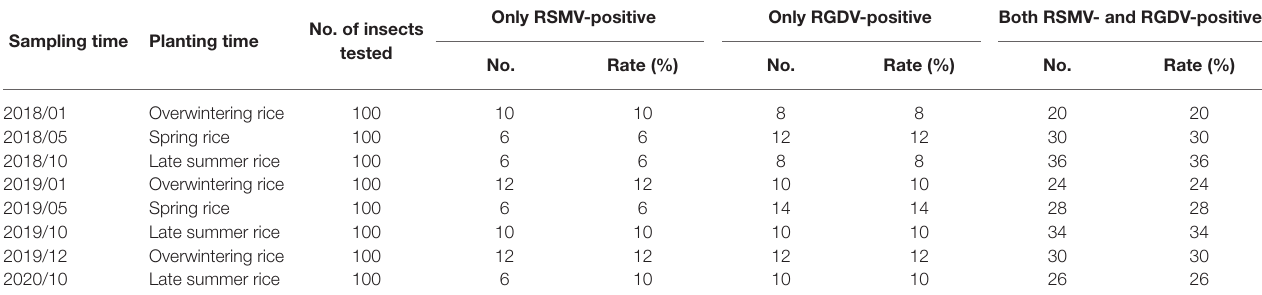
Sampling time Planting time